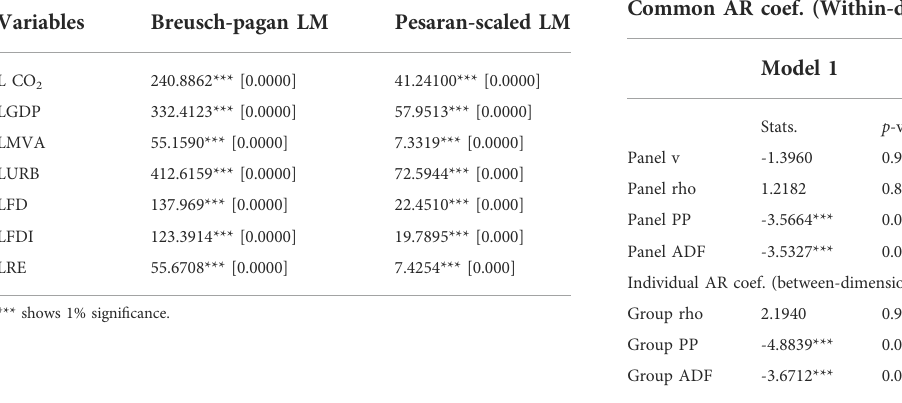
TABLE 5 Pedroni cointegration test.